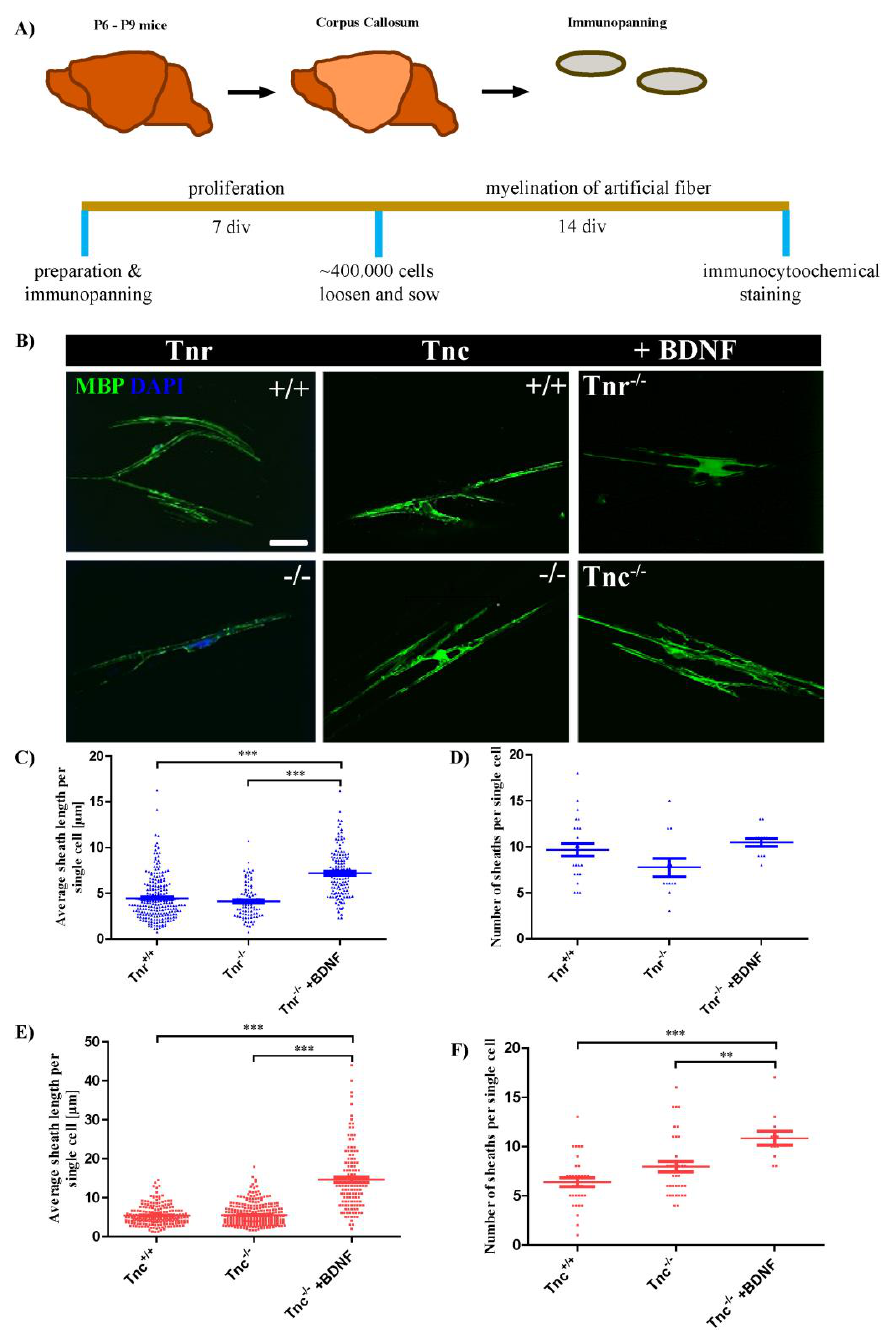
Figure 1. Tnc retards whereas Tnr and BDNF promote myelination by OPCs in an artificial fiber assay. ( A ) OPCs from P6–P9 mice from 129/SV wild-type, Tnc − / − and Tnr − / − mice were prepared via immunopanning and cultivated for 7 div . OPCs were seeded on artificial fibers and cultivated for 14 div . Exemplary photomicrographs of artificial poly-L-lactic acid electrospun microfibres with OPCs in myelination medium for 14 div are shown ( B ) Immunocytochemical staining was performed with antibodies against GFAP (to exclude astrocytes) and MBP (green, to determine myelin). Scale bar: 50 µ m. To determine the myelination degree in the different conditions the average sheath length of fibers per single cell ( C , E ) and the number of sheaths per single cell ( D , F ) were determined. In a pilot study, BDNF was added to Tnc − / − and Tnr − / − OPCs to analyze its impact on myelination ( E , F ). A minimum of 35 single cells in 3 independent experiments were analyzed (n = 35, N = 3). For statistical analysis, the unpaired two-tailed student’s test was used ( p ≤ 0.01 **, p ≤ 0.001